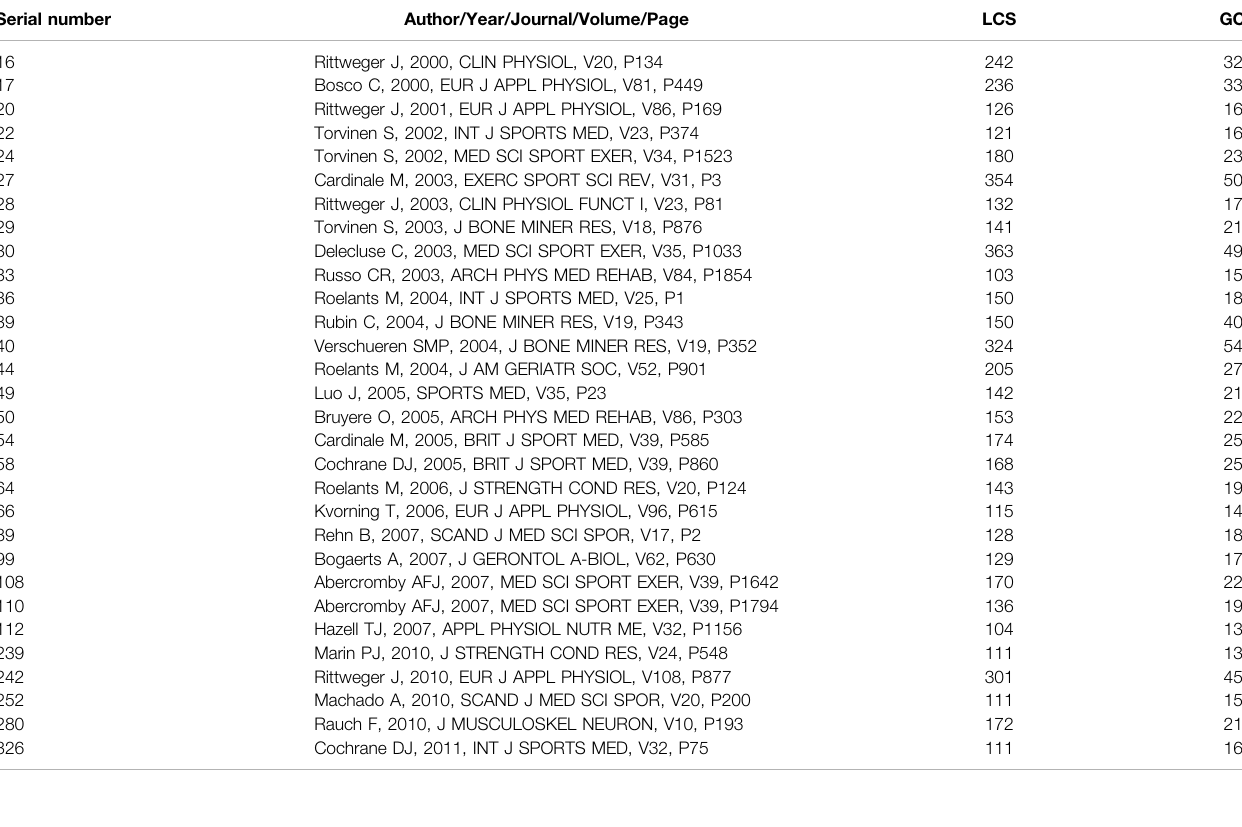
TABLE 6 | Node information of citation chronology map (LCS Count = 30).